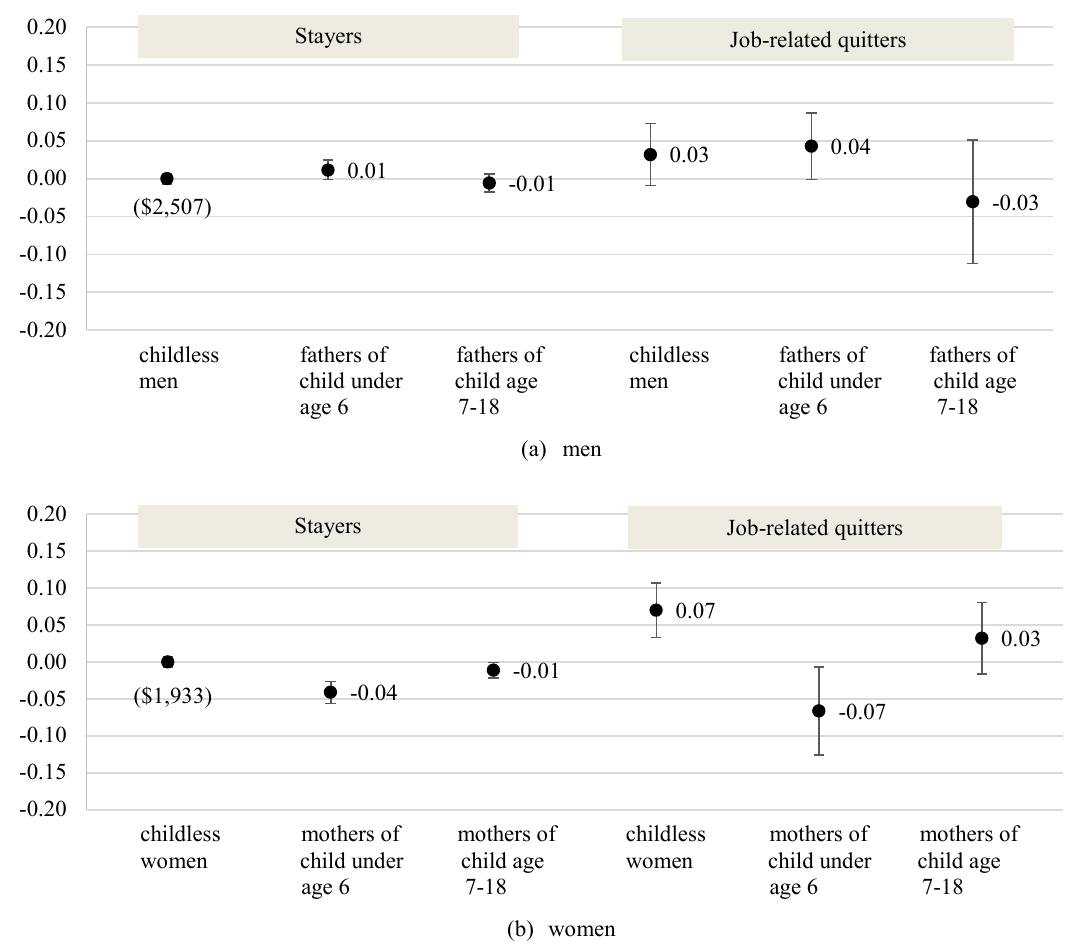
Figure 1. Differences in logged monthly earnings between childless stayers and other workers in the pre-recession data